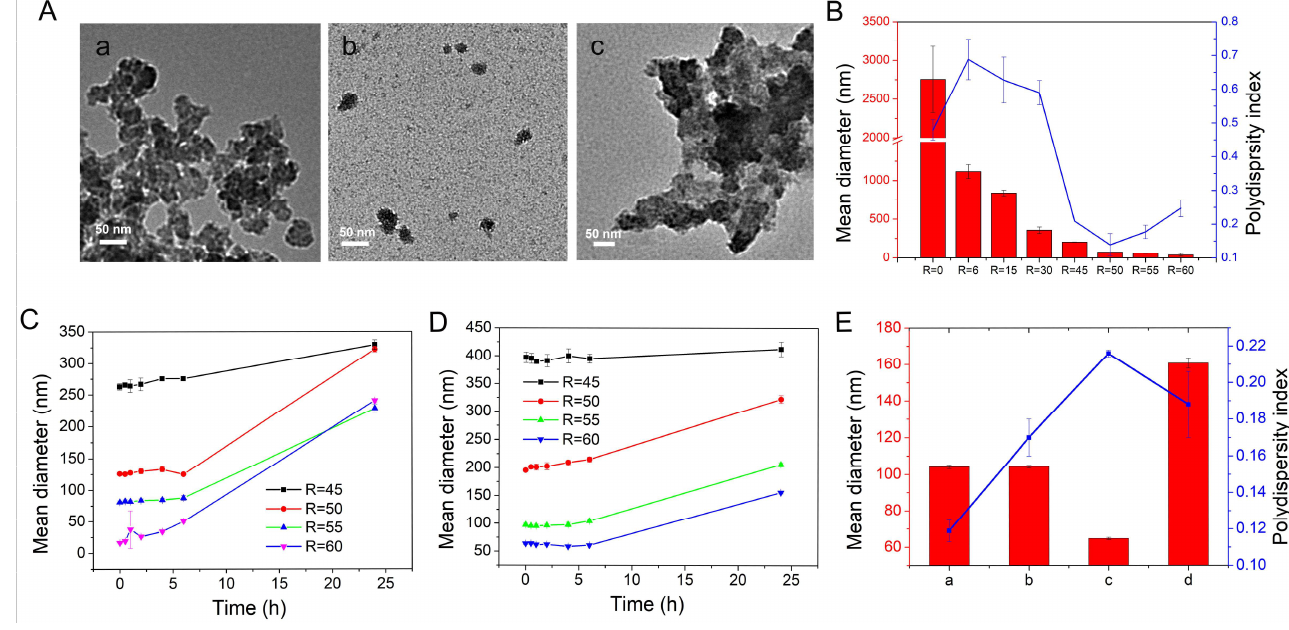
Figure 2. ( A ) TEM images of ( a ) RT MIL100 (R = 0) without purification, ( b ) RT MIL100 (R = 53) without purification, ( c ) RT MIL100 (R = 53) synthesized at 500 rpm, during 4 h and after purification by centrifugation; ( B ) mean diameters and PDI of RT MIL100 (non-sonicated) synthesized at different ratios of acetic acid and trimesic acid (R = 0~60); ( C ) mean diameters of RT MIL100 (non-sonicated) synthesized at 500 rpm at the ratios of R = 45, 50, 55, 60; ( D ) mean diameters of RT MIL100 (non- sonicated) synthesized at 300 rpm with the ratios of R = 45, 50, 55, 60; ( E ) mean diameters and PDI of RT MIL100 (R = 53) prepared at different conditions (( a ): samples at 0 h without purification, ( b ): samples at 4 h without purification, ( c ): the supernatant of the samples at 4 h after centrifugation, ( d ): samples at 4 h after purification and